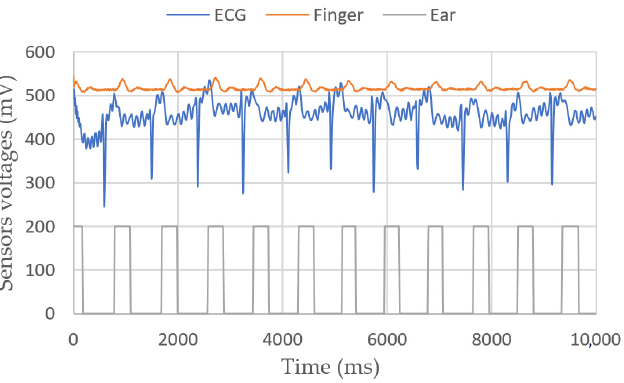
Figure 7. ECG, finger and ear heartbeat sensors’ voltages vs. time for a sitting person.